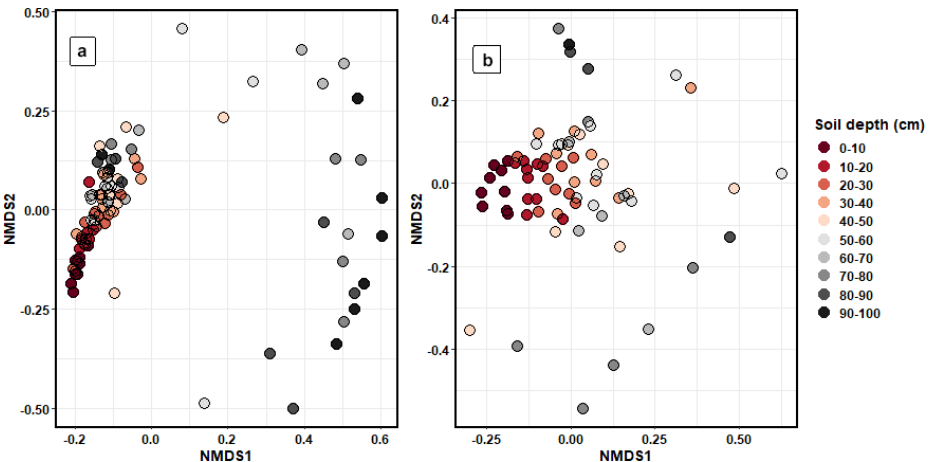
Figure 5. NMDS ordination plots that were calculated using Bray–Curtis dissimilarity matrices showing the differences in (a) bacterial and (b) fungal community composition between the different soil depth